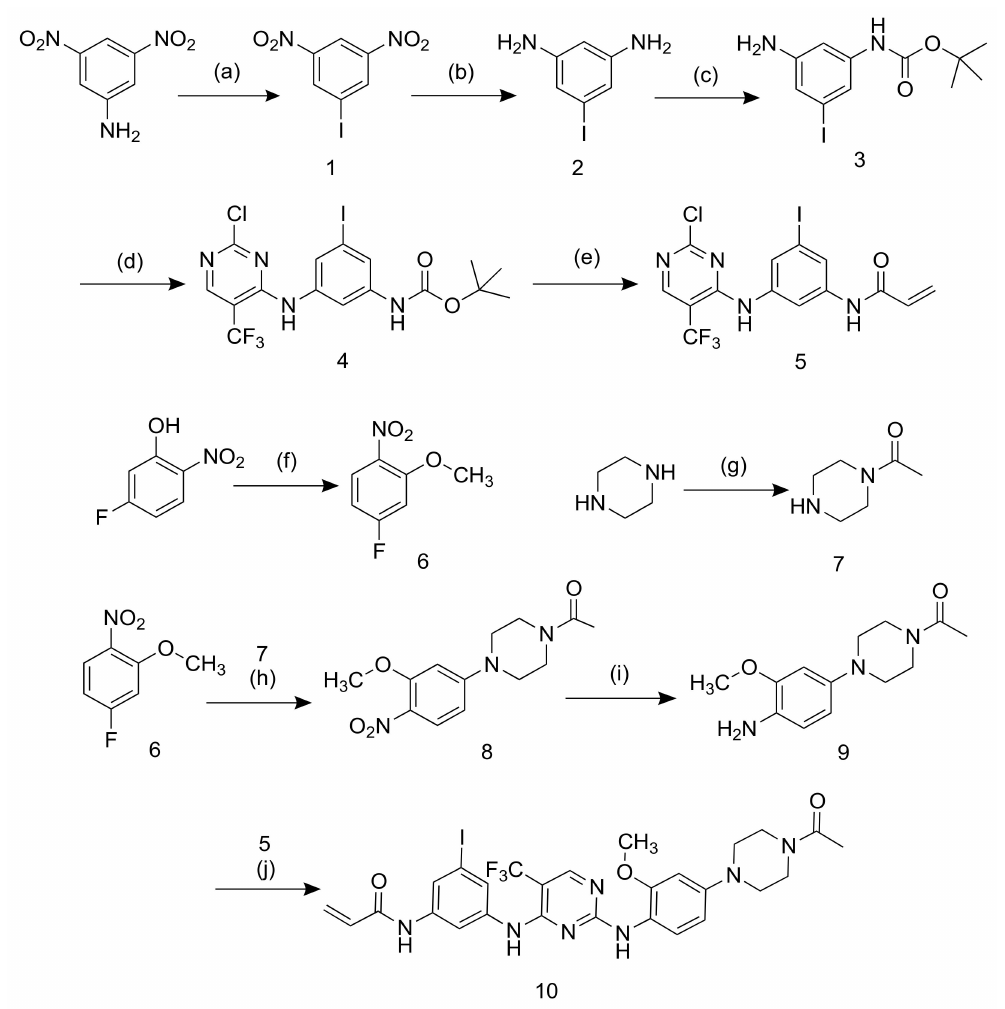
Scheme 1. Synthetic scheme of non-radioactive iodinated compound. Reagent: (a) H 2 SO 4 , NaNO 2